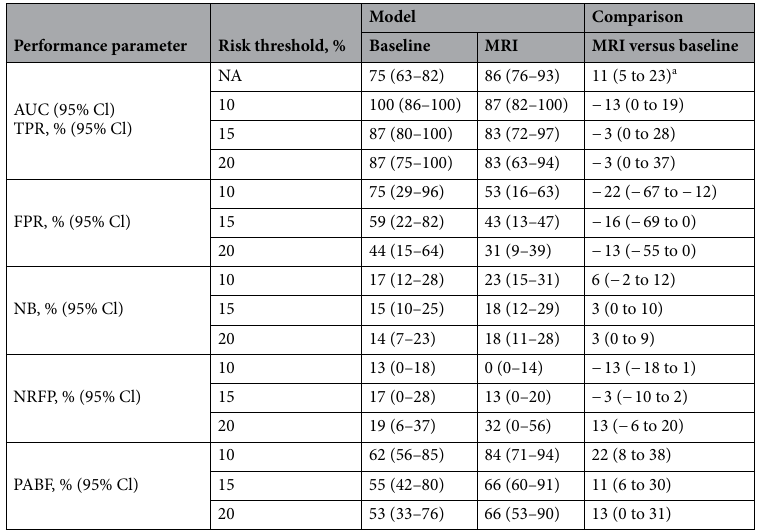
Table 5. Performance of the two Risk Prediction Models in the Validation Cohort. AUC area under the receiver operating characteristic curve; FPR false-positive rate; MRI magnetic resonance imaging; NA not applicable; NB net benefit; NRFP net reduction in false-positives; PABF percentage of avoided biomedical failures; TPR true-positive. rate. a P < 0.05 for the comparison of